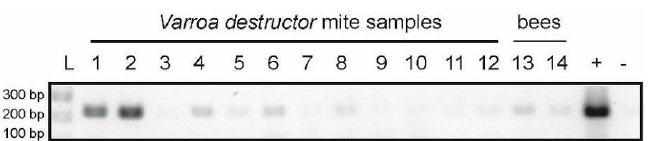
Figure 6. Lake Sinai virus detection in Varroa destructor mites and honey bees. Lake Sinai virus 2 specific PCR was used to detect LSV2 in mite and bee samples. Lanes 1–12 are individual Varroa destructor mite samples, lanes 13 and 14 are honey bee samples ( n = 5 per sample) from the same colony; molecular weight marker (L), positive control (+), and